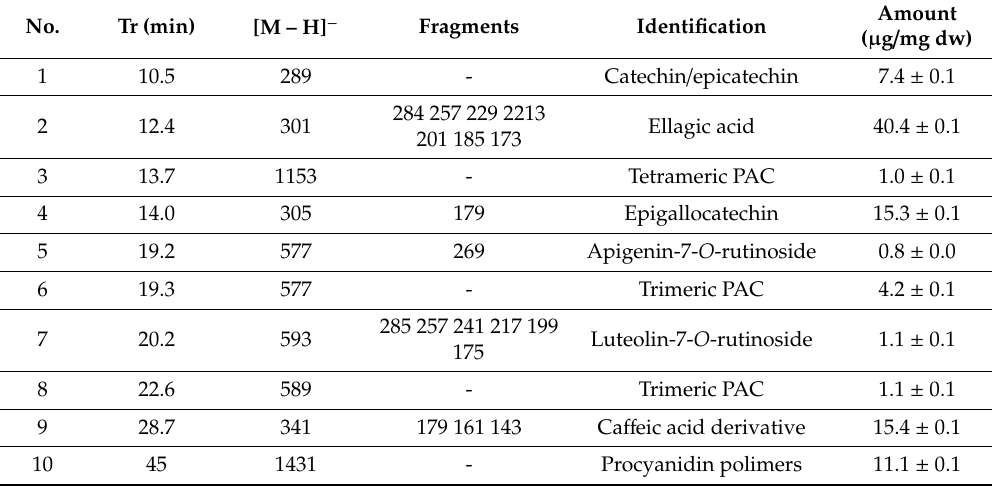
Table 5. Identification and quantification of the phenolic compounds from the optimal extract by LC-MS